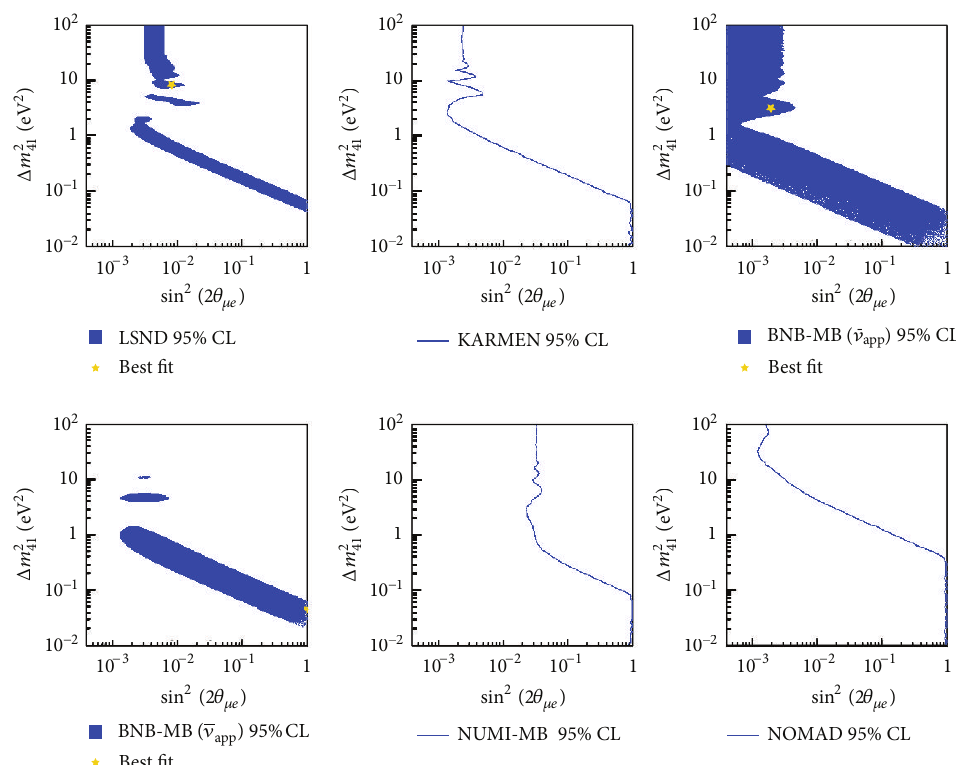
Figure 1: Summary of 𝜈 𝜇 → 𝜈 𝑒 and 𝜈 𝜇 → 𝜈 𝑒 results, shown at 95% CL. Top row: LSND, KARMEN, BNB-MB( 𝜈 ), NuMI-MB( 𝜈 ), NOMAD. See Section 3.2 for details and references. MB( 𝜈 app app